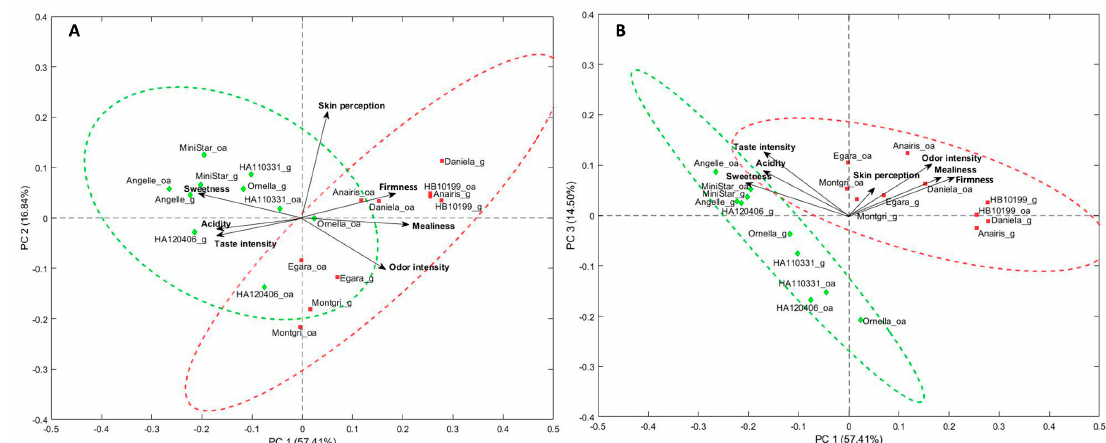
Figure 3. Plot from the three first principal components in the PCA estimated from sensory data ( A ), PC-PC2; ( B ), PC1-PC3. Green points = cherry; red points = fresh market. The dashed lines represent the 95% confidence ellipses for each varietal group (cherry, fresh market). Growing environment is signaled as “g” (greenhouse) or “oa” (open air).